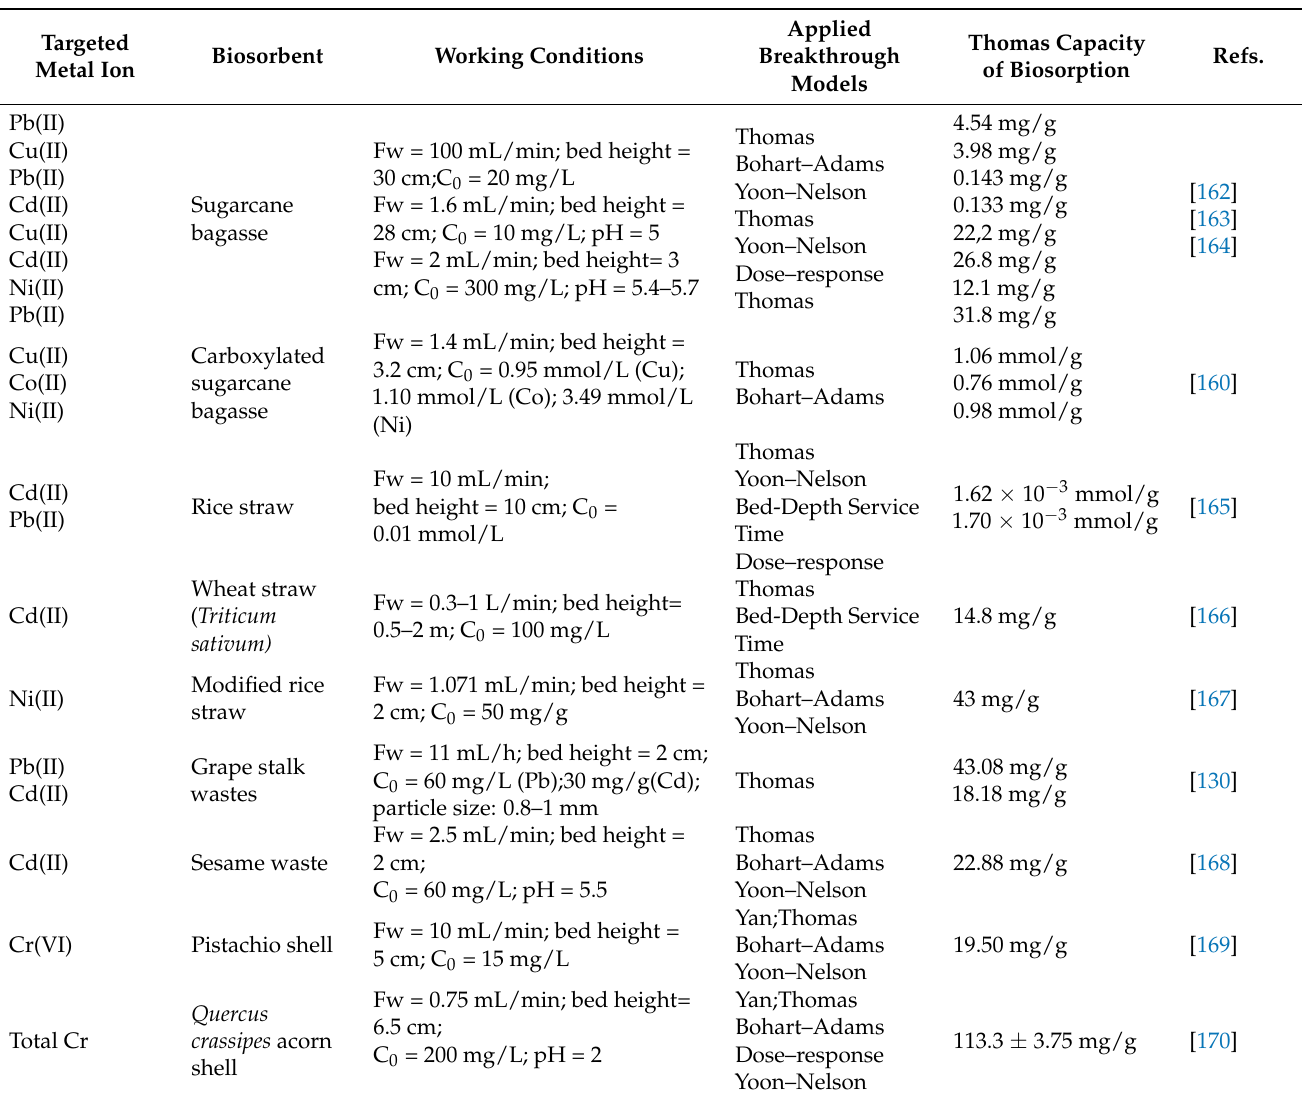
Table 3. Renewable resource biosorbents for fixed bed column removal of heavy metals from synthetic